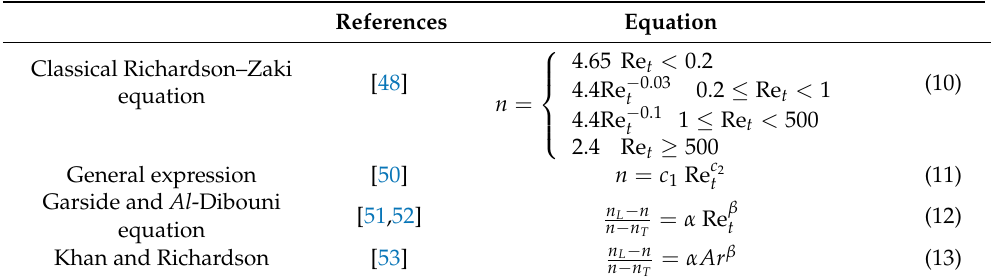
Table 2. Richardson–Zaki index equations from